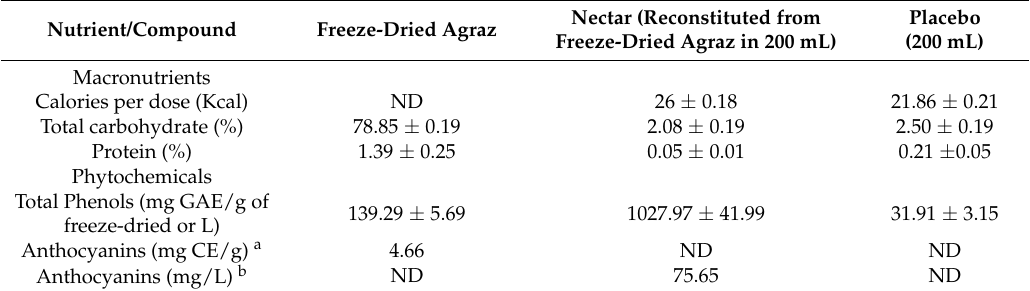
Table 1. Phytochemical composition and nutrient analysis of the freeze-dried agraz, nectar, and placebo. Nutrient/Compound Freeze-Dried Agraz